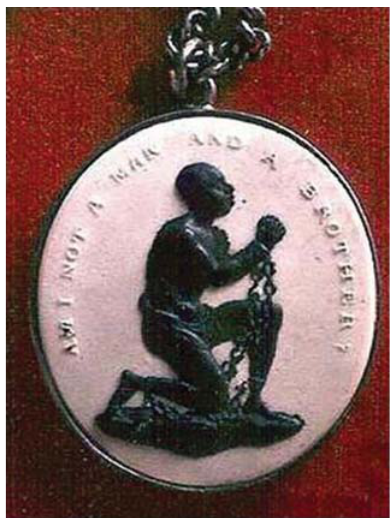
Figure 1. Example of a medallion de- signed by Josiah Wedgwood, circa 1787, to raise public awareness of the suffer- ing brought about by the slave trade. Image used by permission of http://thepot-